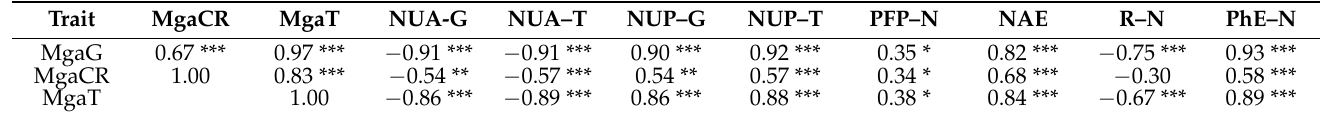
Table A3. Correlation matrix of magnesium accumulation and indices of nitrogen use